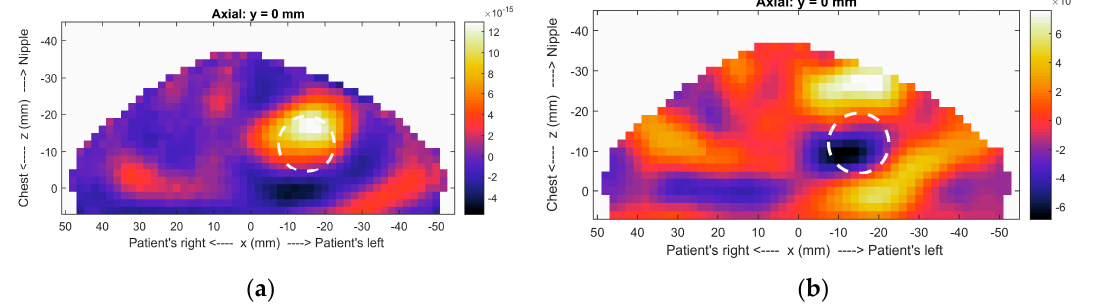
Figure 11. Radar images of realistic breast model formed ( a ) with and ( b ) without surface estimate. In ( b ), the image is limited to the breast region in order to enable comparison. The circle indicates the actual location of the tumor. Both images are formed with 2 mm voxel size, so the outline of the breast is not indicative of the surface estimate.